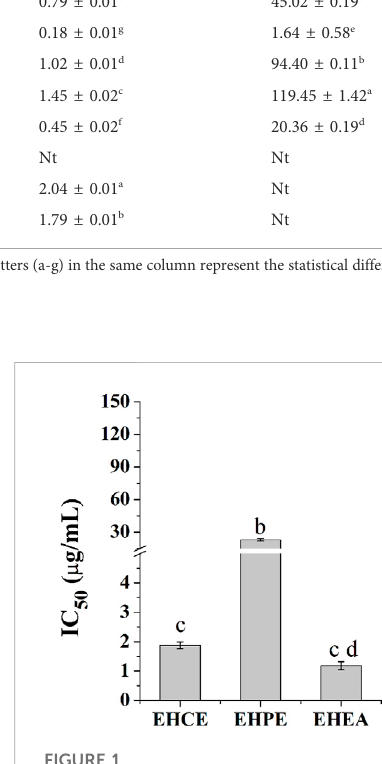
FIGURE 1 α -Glu inhibitory effects of E. humifusa crude extract (EHCE) and the different fractions. Petroleum ether (EHPE), ethyl acetate (EHEA)and n- butanol (EHNB). The label letters (a – d) represent the signi fi cant difference at p -value < 0.05 by ANOVA